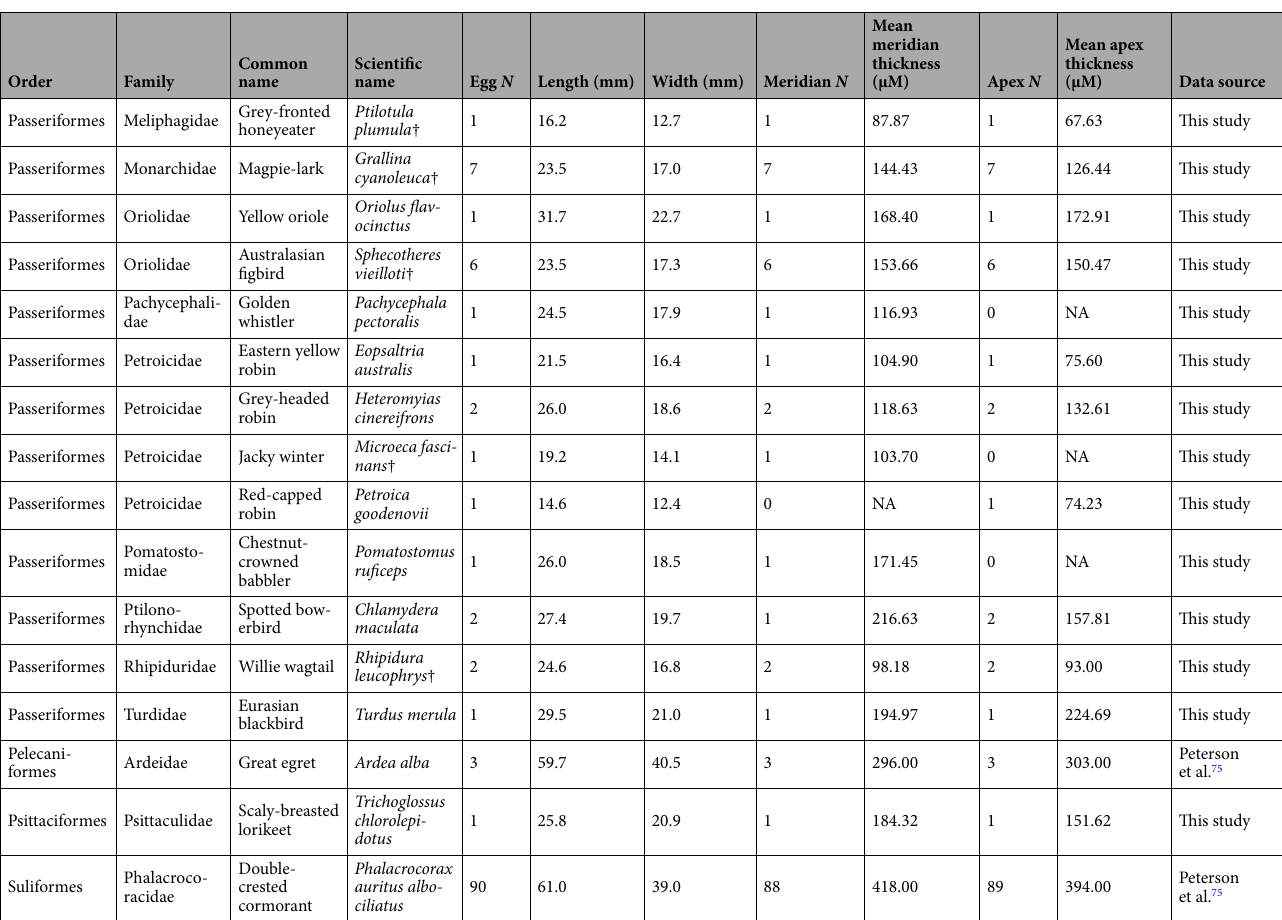
Table 2. Egg size and eggshell thickness of bird species from 12 avian orders and 34 families. *Brood parasitic cuckoo species. † Host species of the cuckoos in this